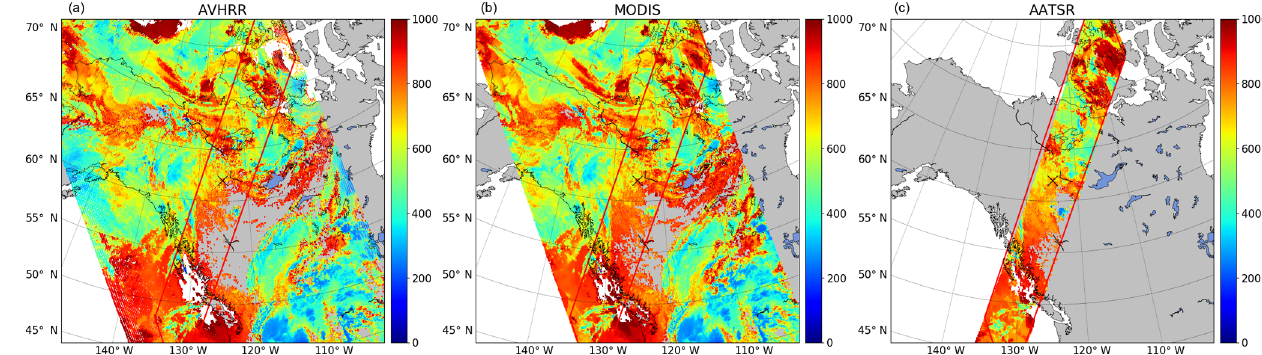
Figure 3. CTP retrieval values for study area NA2 with data from AVHRR (a) , MODIS (b) , and AATSR (c) .